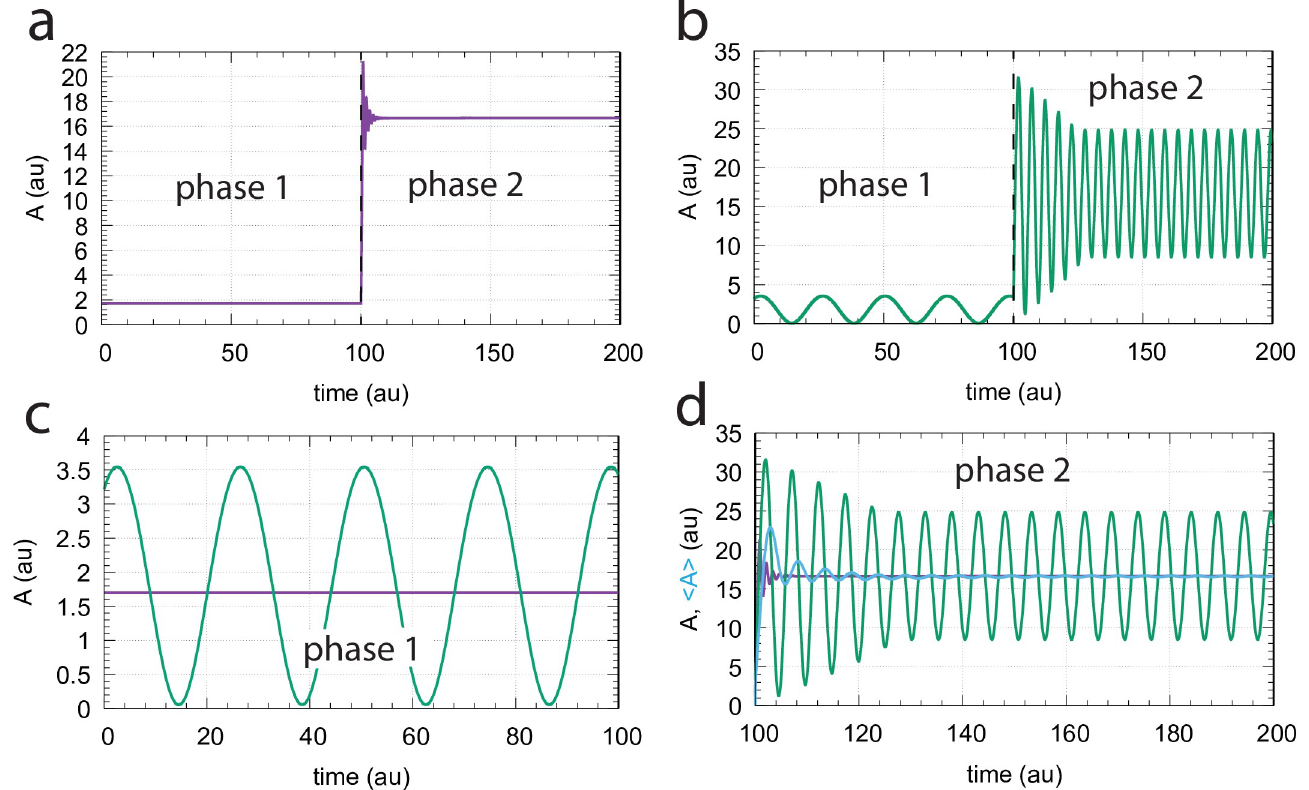
Fig 5. Comparison between oscillatory and non-oscillatory controller modes of combined motifs m3 and m5. (a) non-oscillatory behavior when rate of A is given by Eq 1. (b) Oscillatory behavior when describing _ A by Eq 6. (c) Comparison between oscillatory and non-oscillatory behavior in phase 1 when k 1 = 1.0 and ¼ 1 : 7 . (d) Comparison between oscillatory and non-oscillatory behavior in phase 2 when k 1 and k 2 = 10.0. Average value of oscillatory A , < A > , is precisely at A in set ¼ 16 : 7 . Other rate constants: k 3 = 3.0, k 2 have changed to respectively 10.0 and 0.0. < A > (blue line), approaches rapidly the set-point of the outflow controller A out set ; K 0 (when applied) both 1 × 10 − 6 , and K I 1 = 8.5. Initial concentrations for phase 1, k 4 = 50.0, k 5 = 1 × 10 − 8 , k 6 = 0.7, k 7 = 0.5, k 8 = 1.2, k 9 = 1.0, k 10 = 1 × 10 − 6 , K M M panel a: A 0 = 1.700, E = 1.136 × 10 − 9 , E = 2.286 × 10 1 ; Initial concentrations for phase 1, panel b: A 0 = 3.219, E = 2.395 × 10 − 9 , E = 1.322 × 10 1 . out ,0 in ,0 out ,0 in ,0